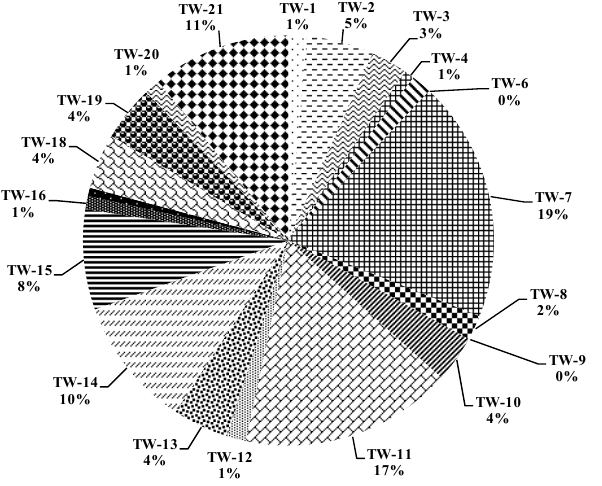
Figure 4. Relative abundance of OCP in different borewell samples (Post-monsoon)